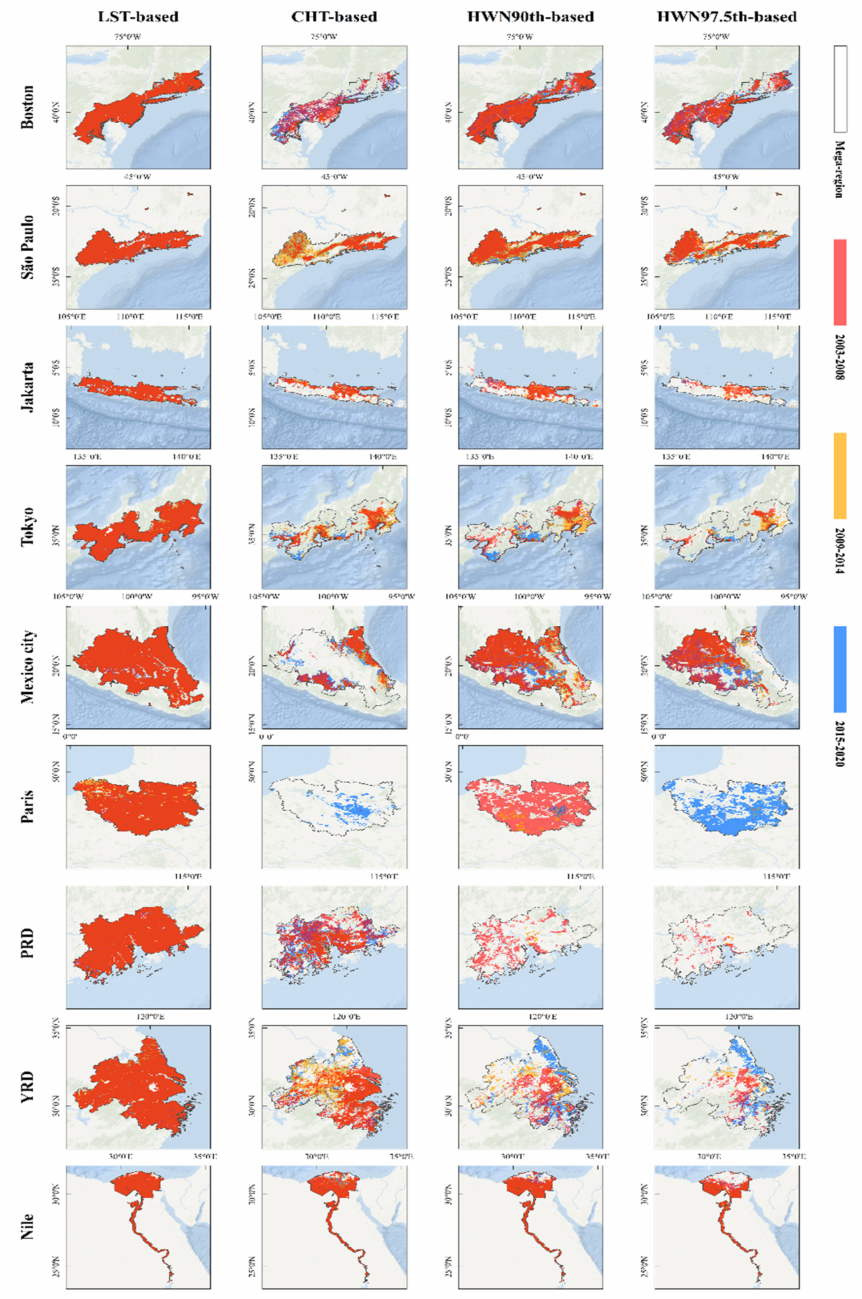
Figure 6. Spatial distribution of percolation-based hotspots in the 9 mega-regions in three time